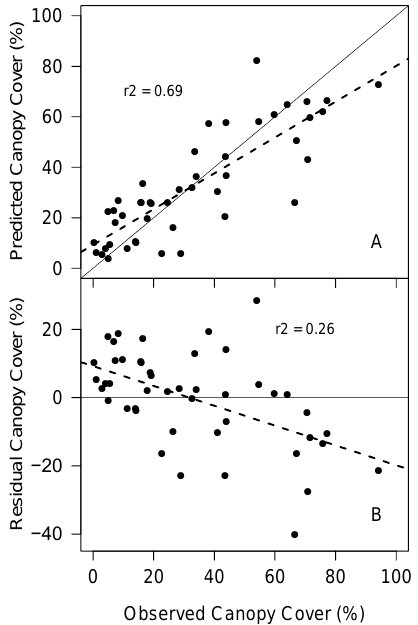
Figure 5. Map of canopy cover across the study area predicted using the relationship between DN and field observations shown in Figure 4.